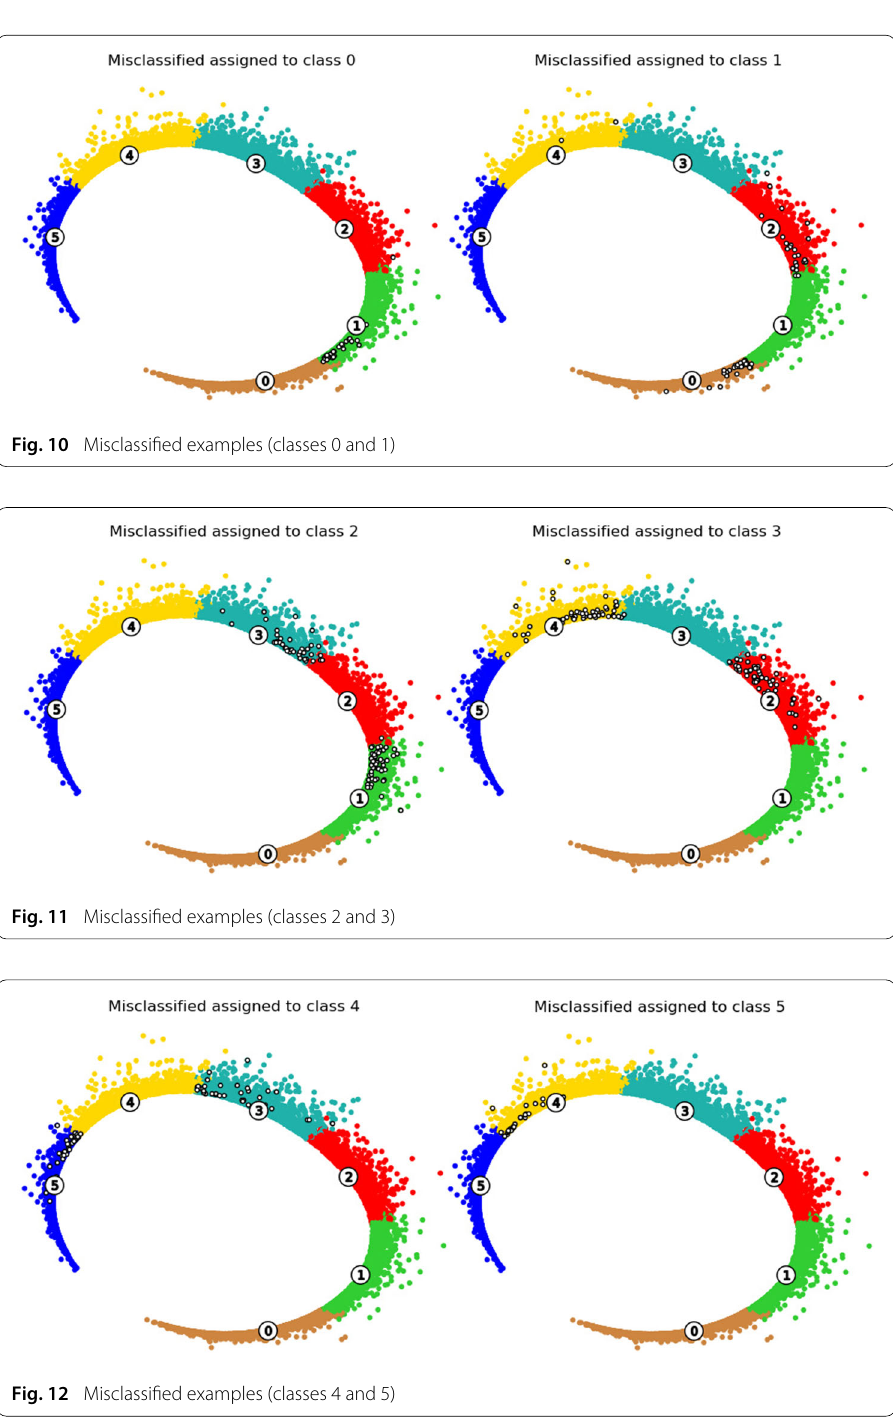
time for the selection of the best reduced-order model is decreased by a factor of 60 when using the ROM-net’s deep classifier F K instead of the true classifier K K